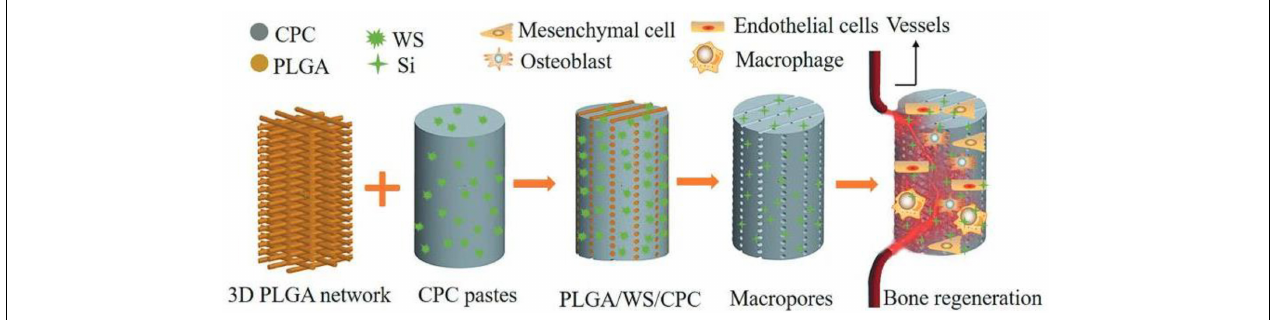
FIGURE 7 | Schematic diagram of calcium phosphate-based composite cement with an embedded 3D plotted PLGA network and bioactive wollastonite for osteogenesis and angiogenesis. Reproduced from Qian et al. (2019) with permission from Wiley (Copyright